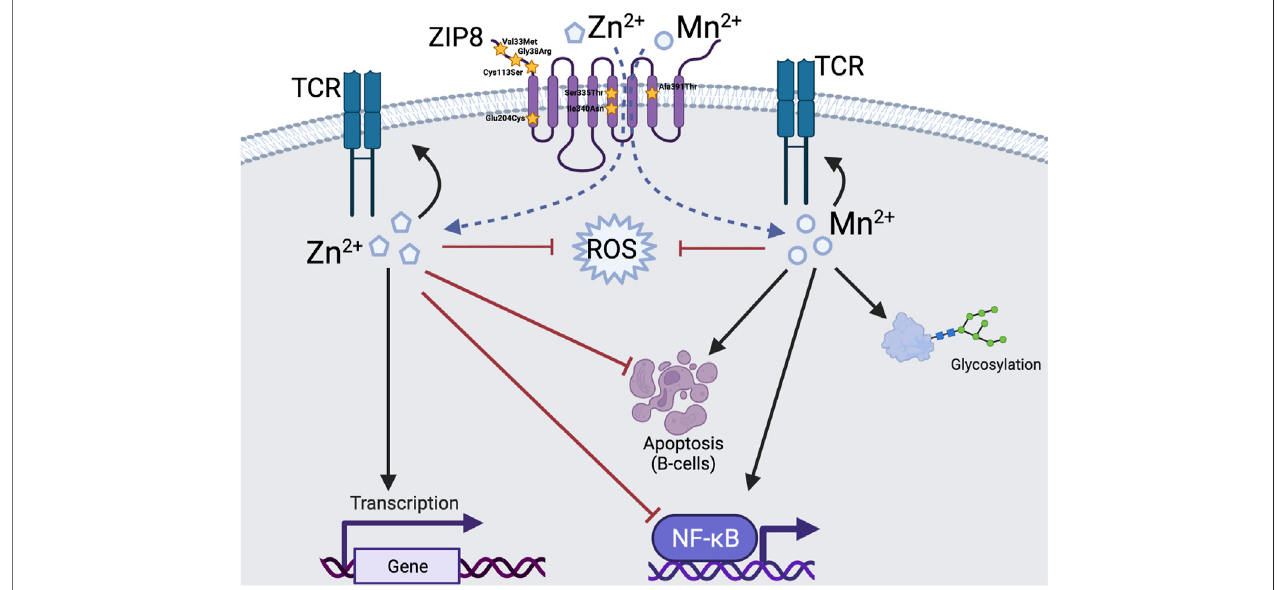
FIGURE 1 | Comparison of the roles of zinc and manganese in immune-mediated host defence against infection. Zn de fi ciency is common worldwide and physiologicalZnconcentrationsprotectagainstinfectionsby:triggeringavarietyoftranscriptionfactorsinvolvedintheimmuneresponse,preventingapoptosisofBcells andinhibitingtheNF- κ Bpathwayfollowingintracellulartranscript via ZIP8.IncontrastMnde fi ciencyisrareandithelpsprotectagainstinfectionbutdifferentmechanisms that include acting as cofactor for glycosyltransferase enzymes essential for post translational protein glycosylation, enhancing apoptosis of B cells and activating the NF- κ B pathway. Whereas each metal has contrasting and distinctfunctions, they both have antioxidant properties and help facilitate T cell receptor (TCR) signalling. Stars indicate the common polymorphic variants of ZIP8. Red arrows indicate inhibition, black arrows indicate activation.